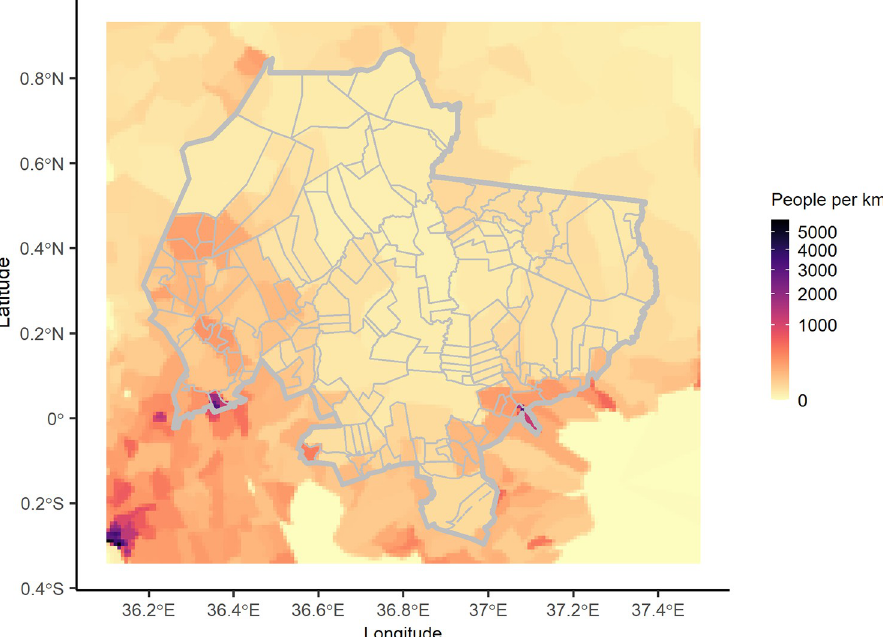
Fig 1. Map of Laikipia County showing underlying human density and patches used in the spatial model. Human population per square kilometre for Laikipia county and the surrounding areas is shown, based on population counts available at https://sedac.ciesin.columbia.edu/data/set/gpw-v4-population-count-rev11 [46]. Grey lines indicate patch boundaries with the thicker line indicating the border of Laikipia County. Patch boundaries were modified from a shapefile of property boundaries from Mpala Research Centre, Laikipia County, Kenya [47].